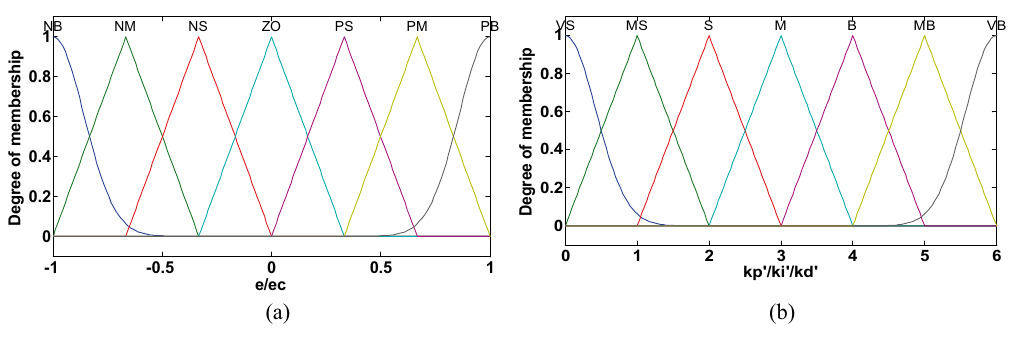
Figure 5. Membership function of FLS2: ( a ) input variables ( b ) output